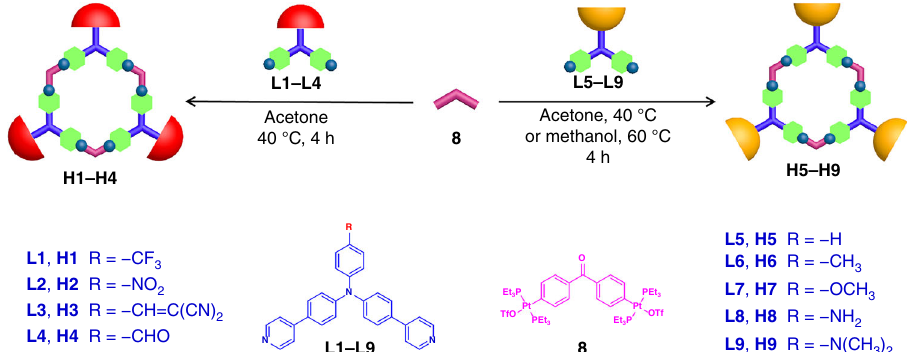
Fig. 1 Self-assembly of 120° triarylamine-based dipyridyl donor ligands L1 – L9 and 120° di-Pt(II) acceptor 8 into hexagonal metallacycles H1 –